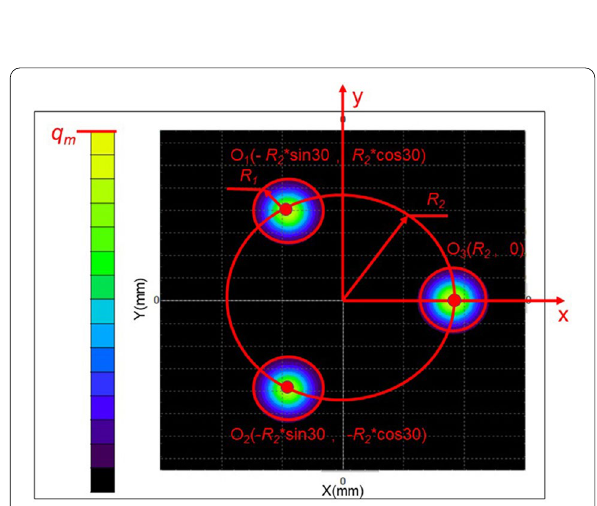
Figure 9 Power intensity contour image of three-beam laser at negative defocus